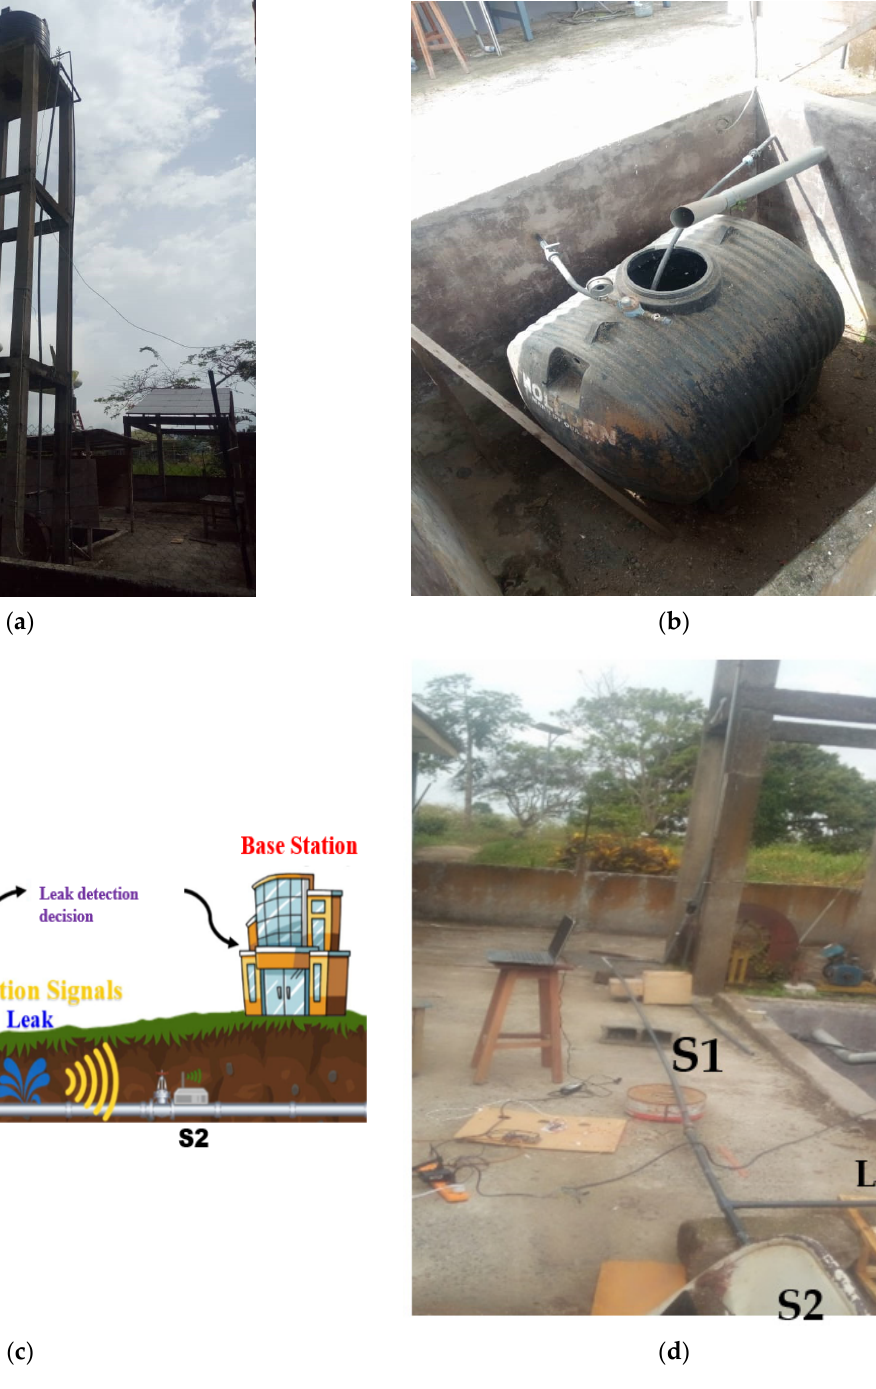
Figure 5. Laboratory testbed setup: ( a ) distribution tank placed at a height of 9 m; ( b ) supply tank found beneath the tower; ( c ) setup model; ( d ) distribution pipeline.